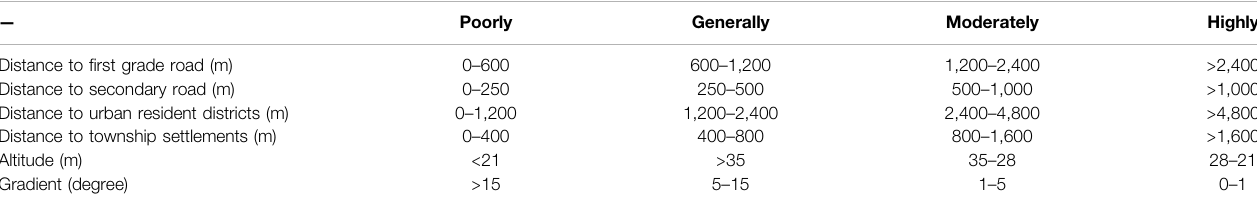
TABLE 2 | Suitability grade of human disturbance, altitude and slope for four migratory bird guilds in DL (Tian et al., 2008a; Wu et al.,